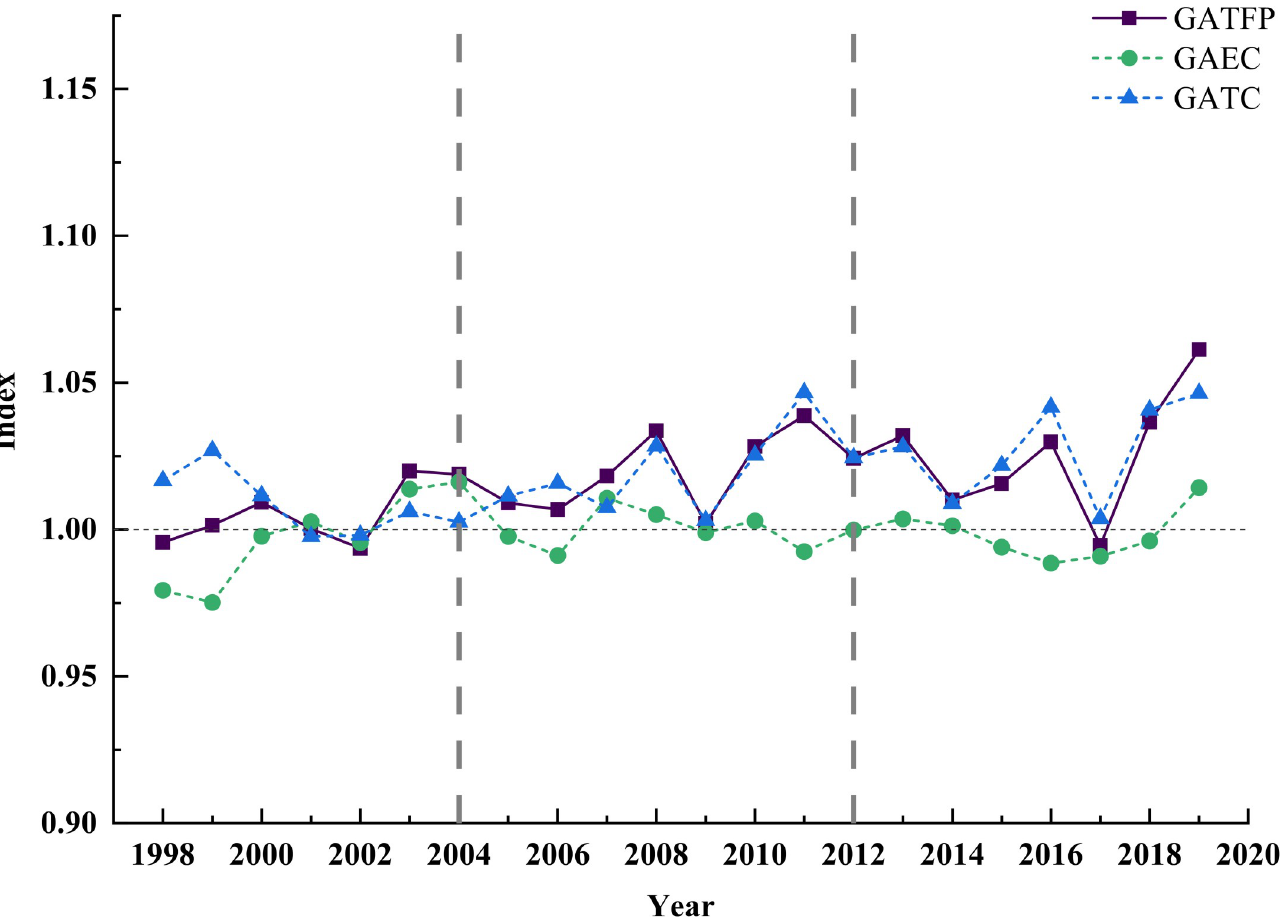
Fig 3. Variation of GATFP and its decomposition terms from 1998 to